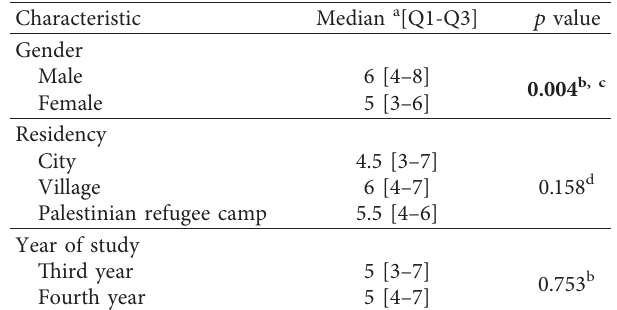
Table 9: Association between nursing students’ demographic characteristics and Vipera palaestinae knowledge score.